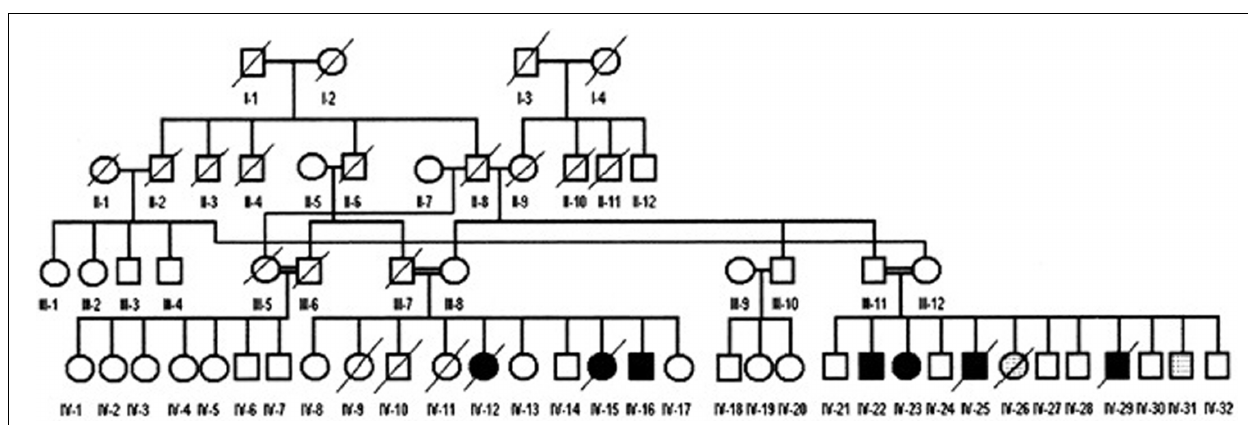
FIGURE 2 | Genealogic tree of the Diyarbakir family. Squares: males, circles: females; filled symbols: cases affected with UTS; symbols filled with dots: bedridden cases. Double horizontal lines represent consanguineous